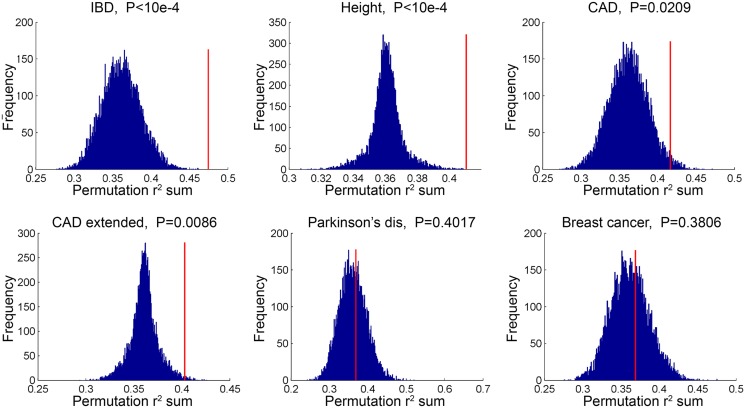
TCF21 target regions contain variation that is in linkage disequilibrium with CAD GWAS variation.SNPs in TCF21 peaks were evaluated for association with GWAS SNPs on the basis of linkage disequilibrium; r2 values for each SNP pair were averaged for the GWAS categories inflammatory bowel disease (IBD), height, CAD, CAD plus CARDIoGRAM+C4D (CAD extended), Parkinson’s disease, and breast cancer. To test for enrichment in each category, permutation analysis was utilized to generate distributions of average r2 using random sets of SNP pairs and statistical significance was assigned to those categories where fewer than 5% of permutations produced an r2 greater than or equal to the true data.